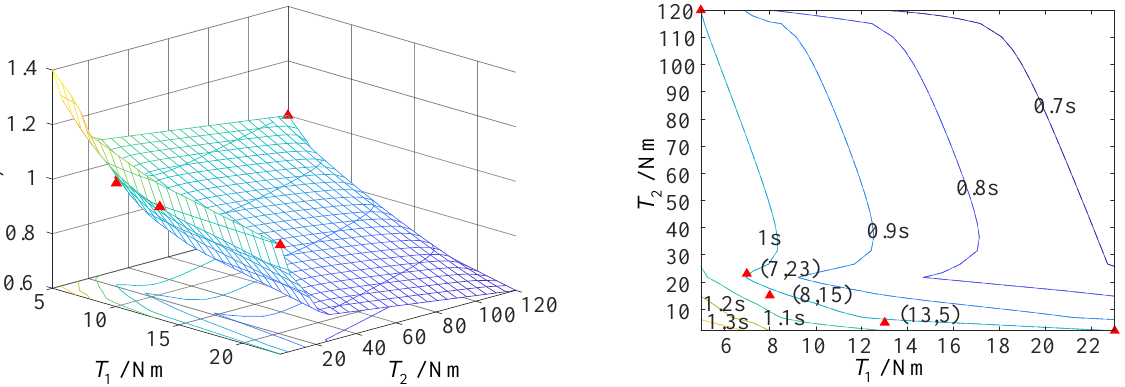
Figure 20. The curve of driving torque and deployment time of folding wing at an airspeed of 50 m/s (non-fixed-axis – fixed-axis stepwise deployment mode).